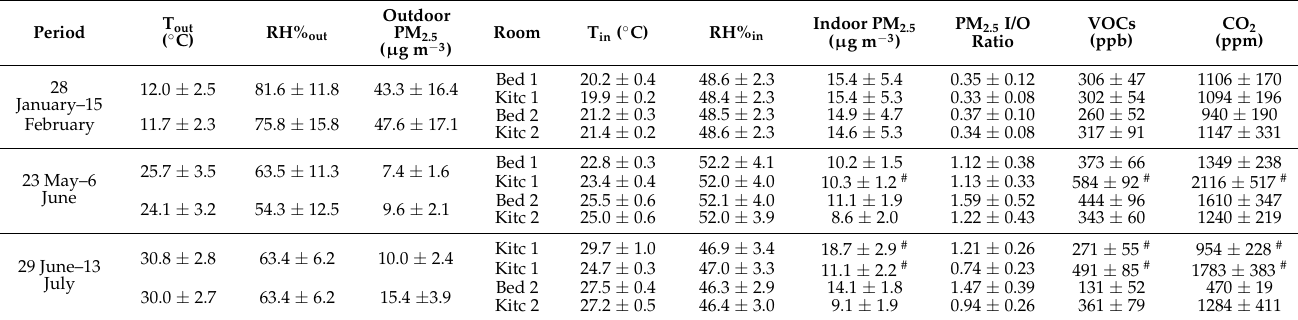
Table 2. Indoor and outdoor daily parameters (24 h) measured during each monitoring campaign in each investigated room (campaign mean ± standard deviation